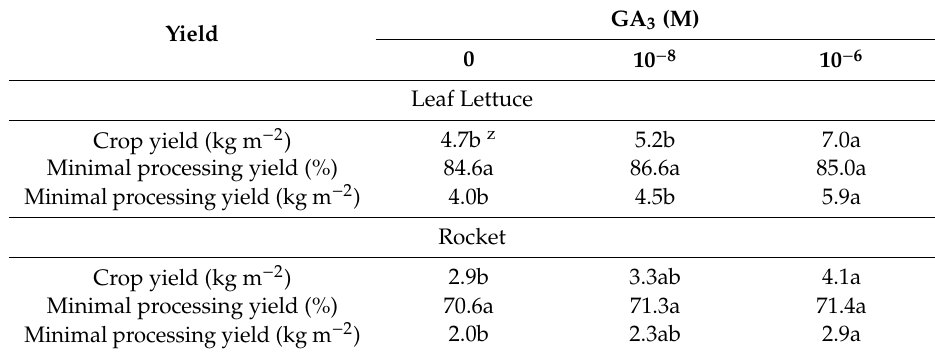
Table 1. Crop and minimal processing yield of leaf lettuce and rocket plants grown in mineral nutrient solutions with di ff erent levels of gibberellic acid (GA 3